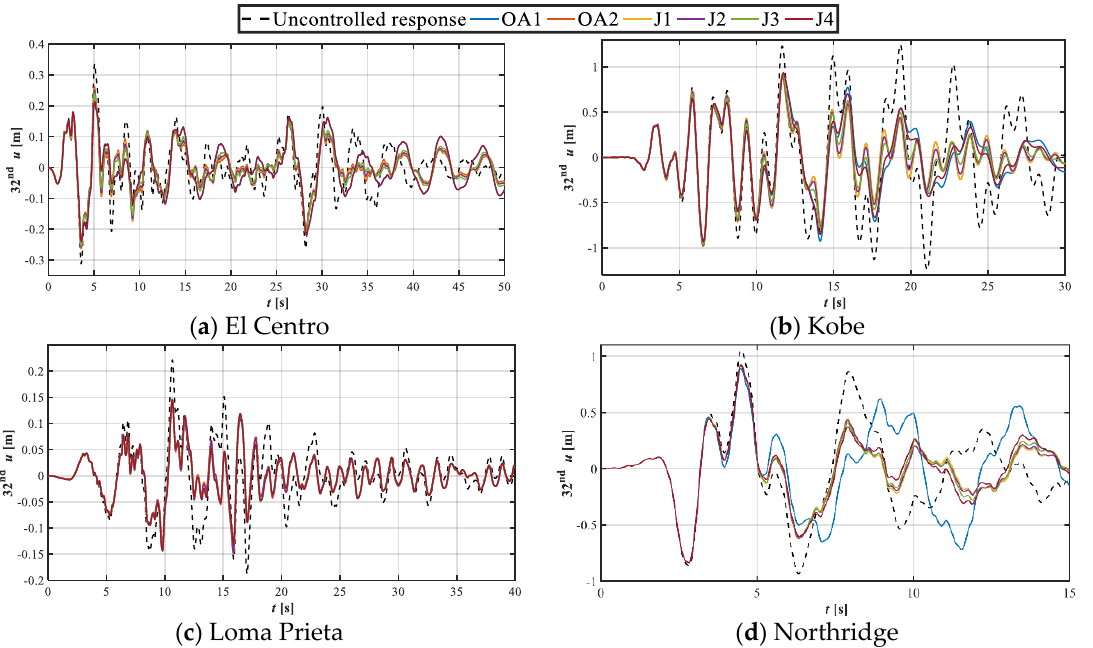
Figure 6. Displacement of the 32nd story of the structure equipped with TMDs with μ = 0.05.